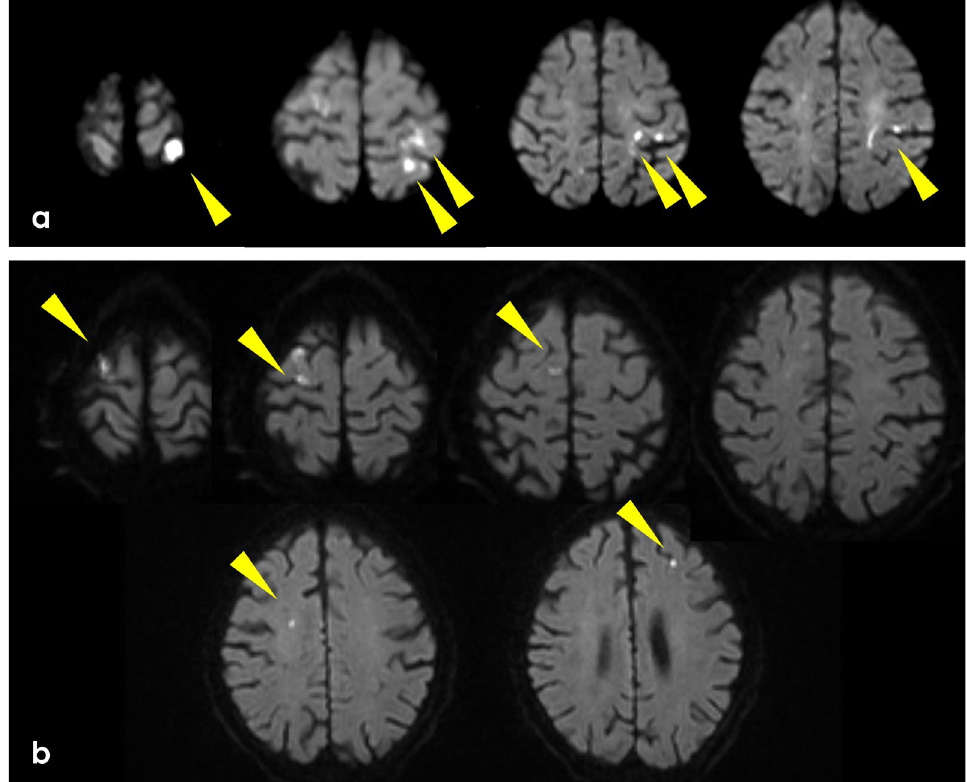
Fig. 1 Diffusion-weighted magnetic resonance imaging at a the initial cerebral infarction and b the second cerebral infarction. a Multiple foci of restricted diffusion in the left parietal lobe. b Many areas of restricted diffusion in the bilateral